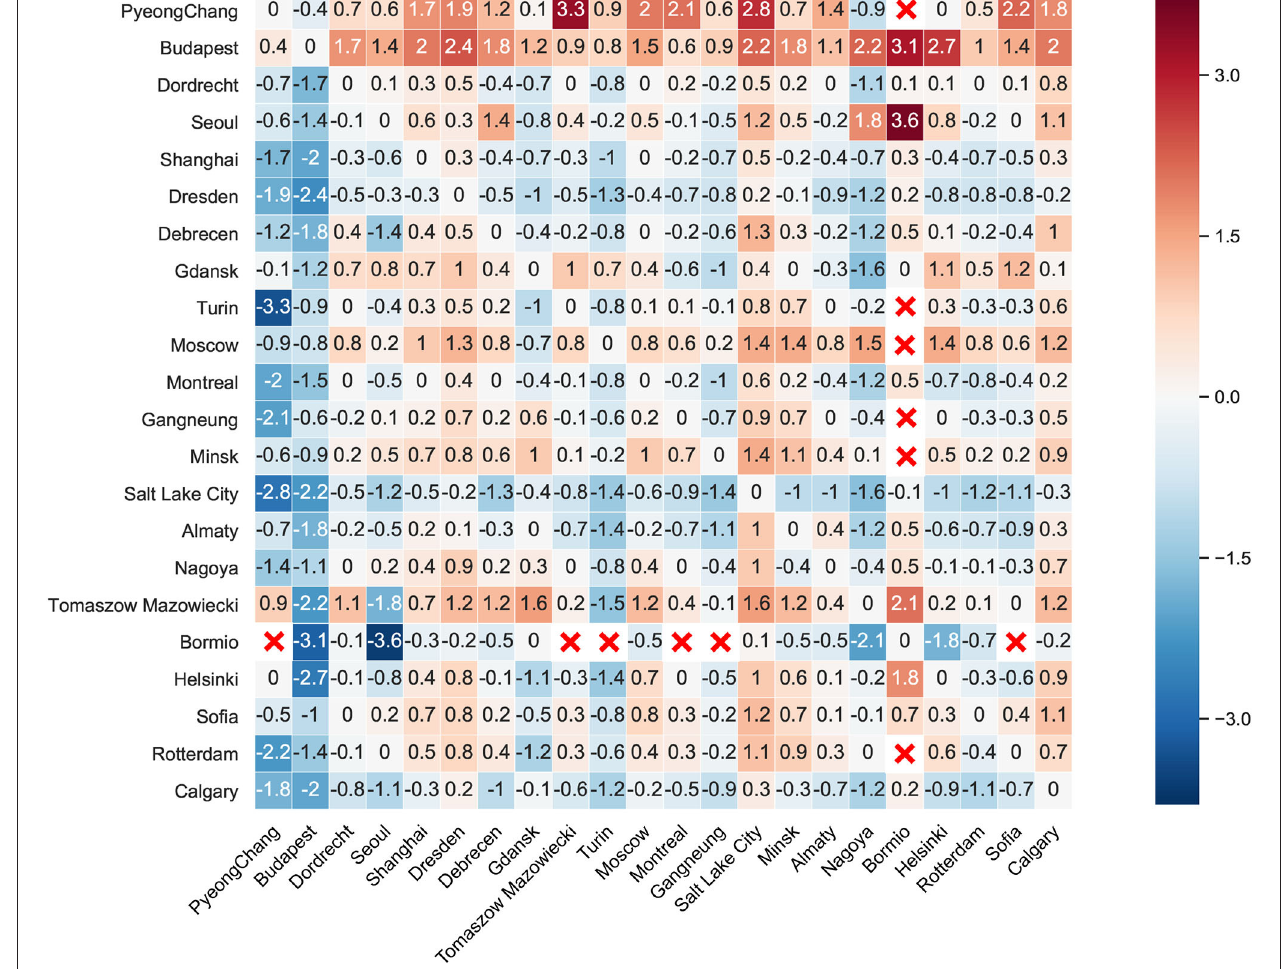
Frontiers in Psychology |